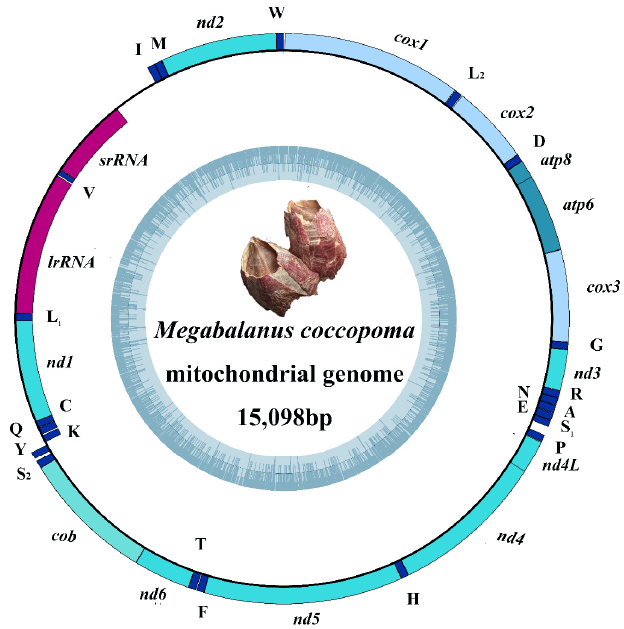
Figure 1. The genetic map of the M. coccopoma mitochondrial genome. The GC content is displayed within the inner ring. Genes encoded on the exterior appeared on heavy strands, while the interior- encoded genes appeared on light strands.